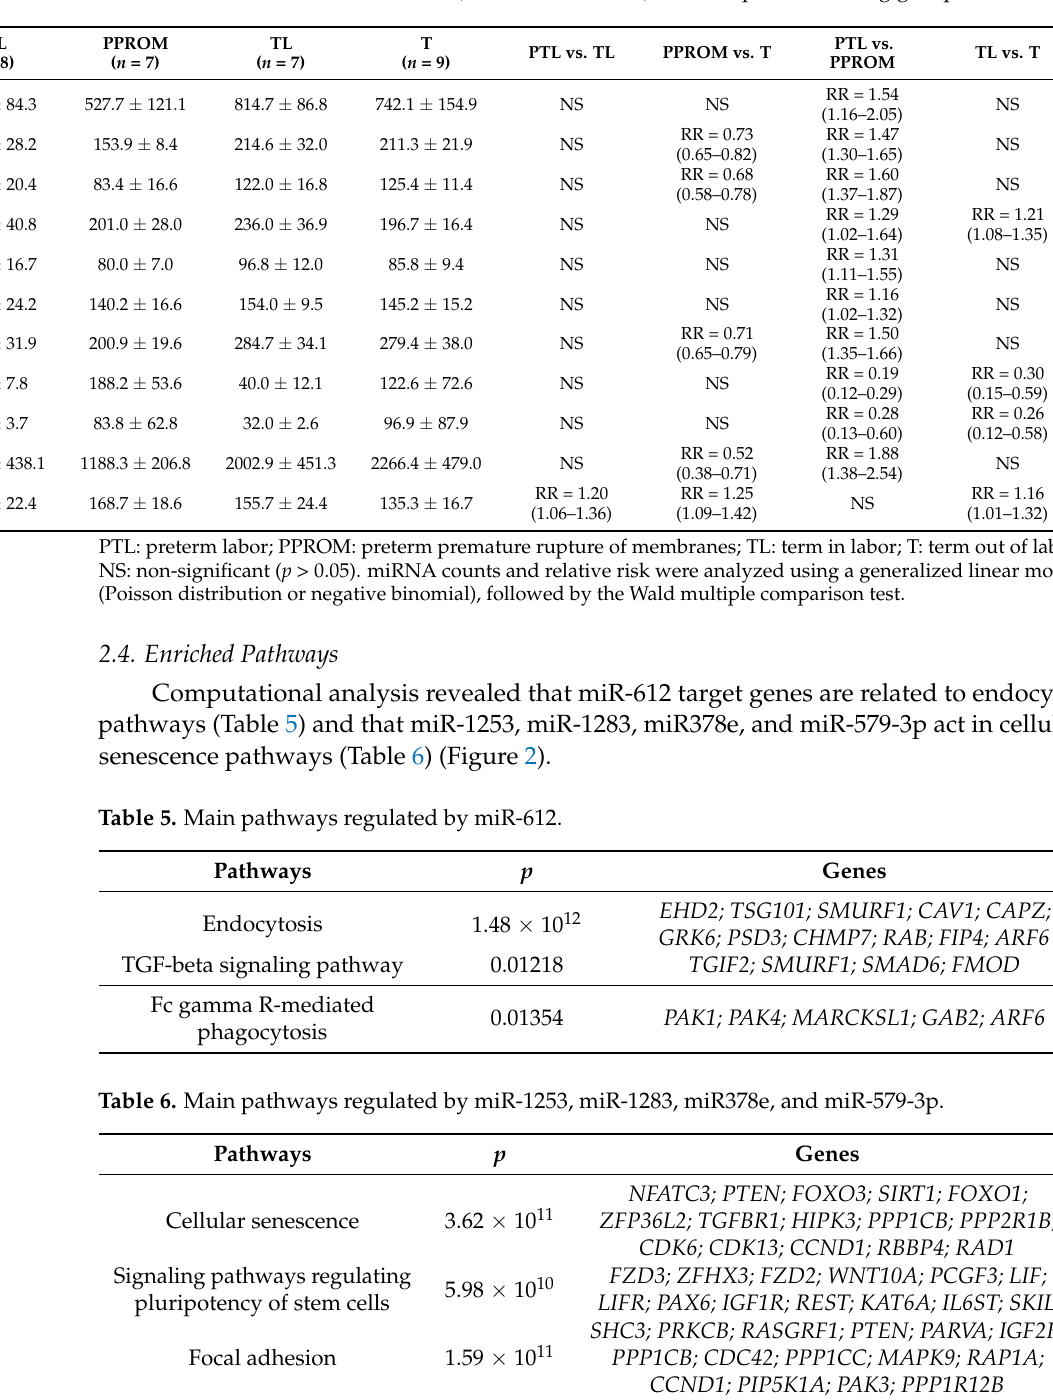
Table 4. Mean count of microRNAs (miRNAs; hsa-miR) and comparison among groups.